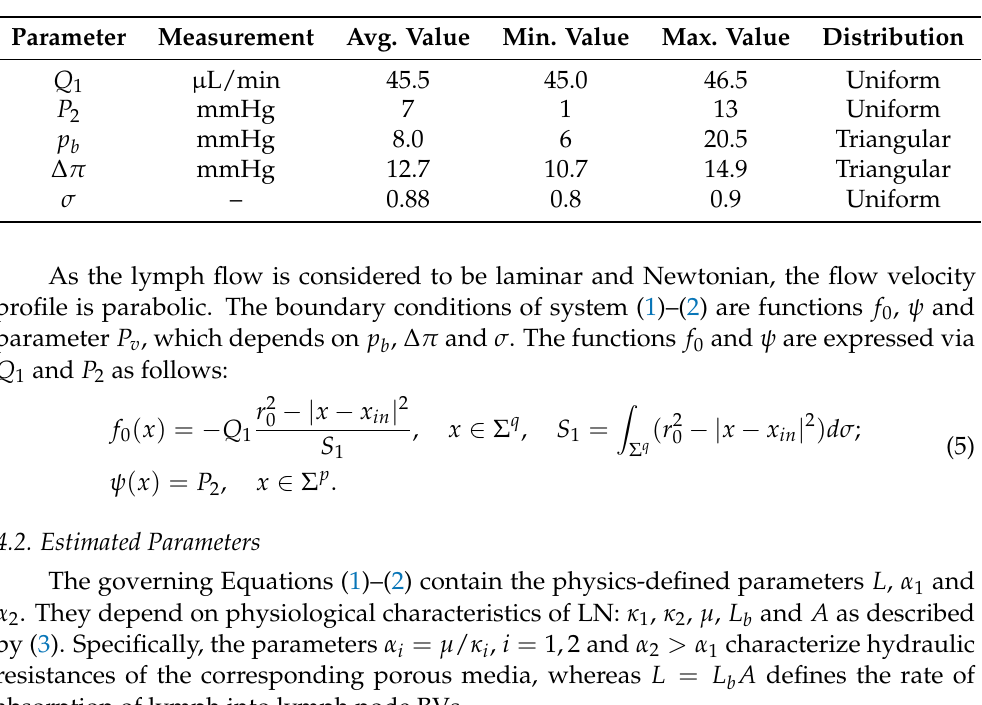
Table 1. Experimental estimates for model parameters determining the boundary conditions: average value, minimal and maximal values and the assumed probability distribution function (based on experimental data from